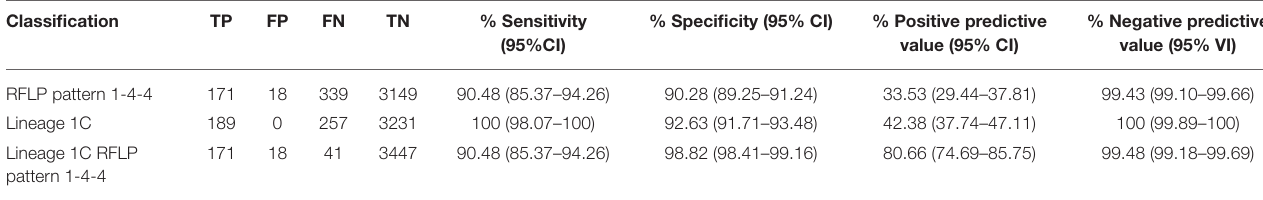
TABLE 1 | Accuracy of RFLP pattern (1-4-4), lineage classification (Lineage 1C), and the combination of both in identifying sequences from the newly emerging variant amongst PRRSV orf5 sequences detected between January 2020 and May 2021.